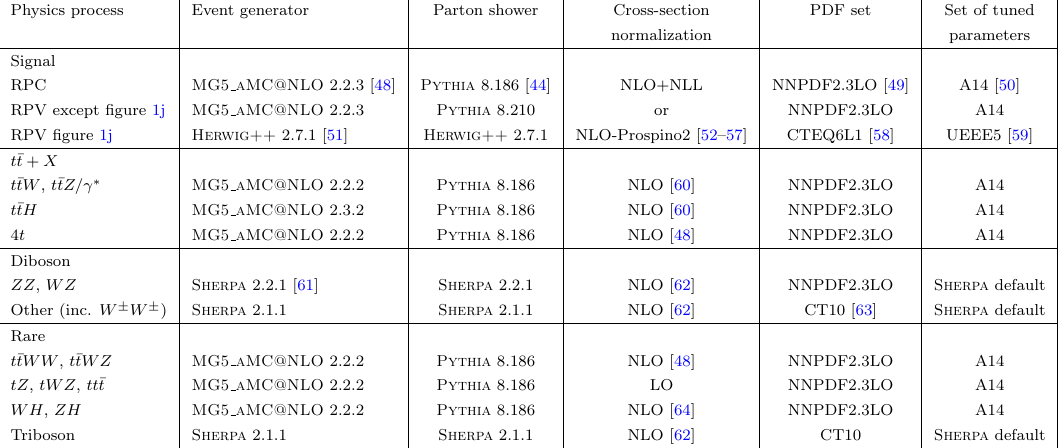
Other (inc. W (cid:6) W (cid:6) ) Sherpa 2.1.1